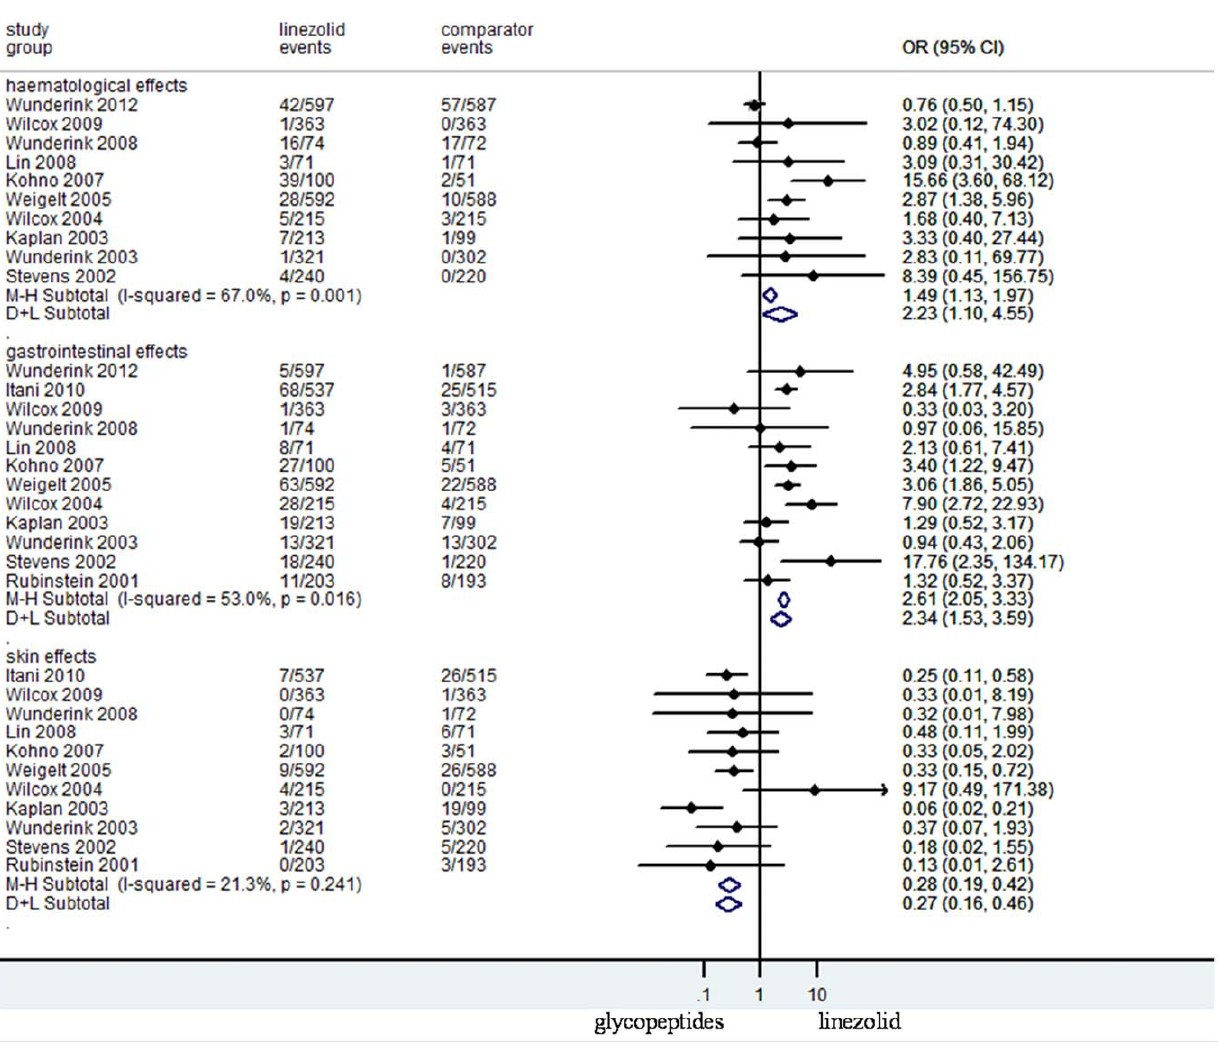
Figure 6. Meta-analyses of haematological, gastrointestinal, and skin adverse effects related to studied regimens. Test of haematological adverse effects for overall effect: Z=2.56 P =0.010; test of gastrointestinal adverse effects for overall effect: Z=7.74 P =0.000; test of skin system adverse effects for overall effect: Z=6.27 P =0.000.